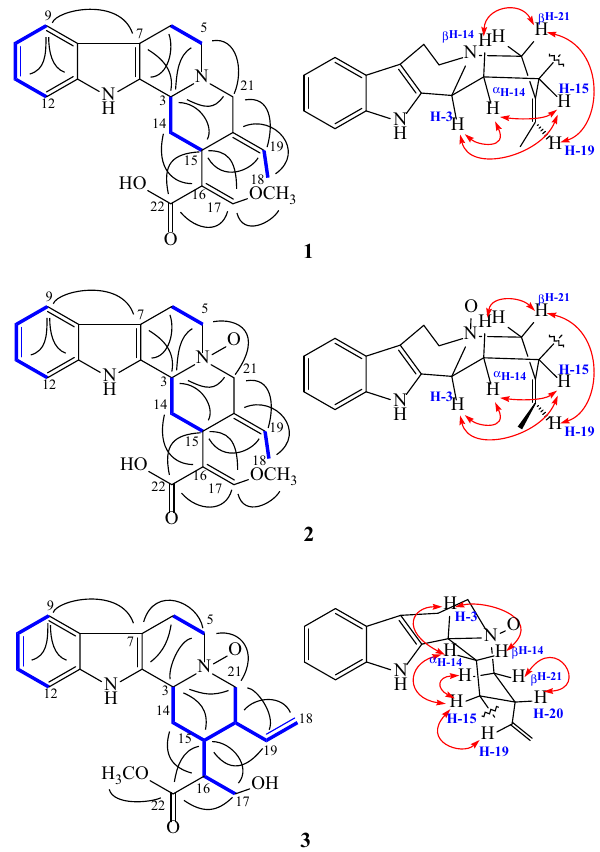
Fig. 2 Selective HMBC ( ? ), 1 H- 1 H COSY ( ), and ROESY ( ) correlations of compounds 1 – 3